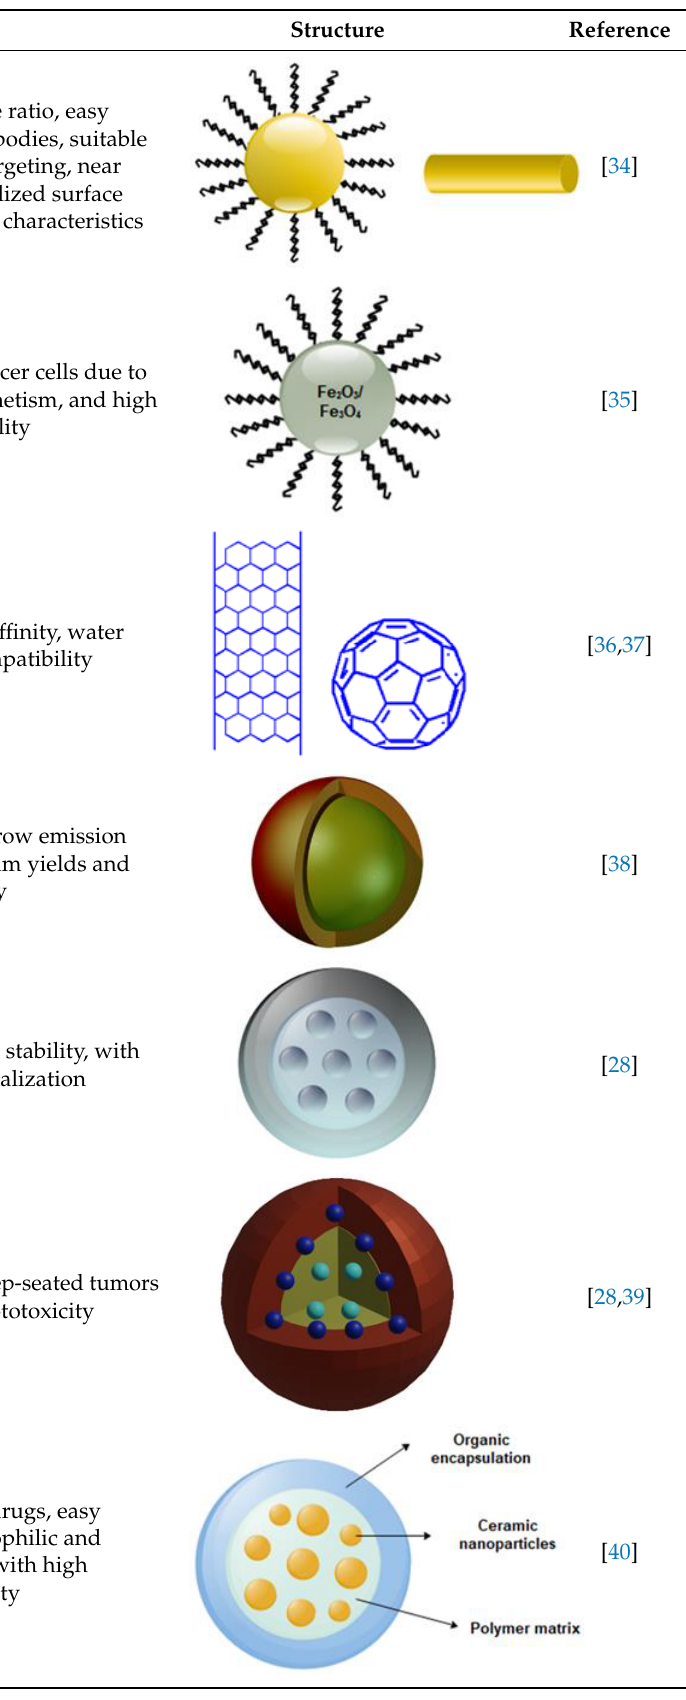
Table 1. Main properties and structures of inorganic nanoparticles (NPs).